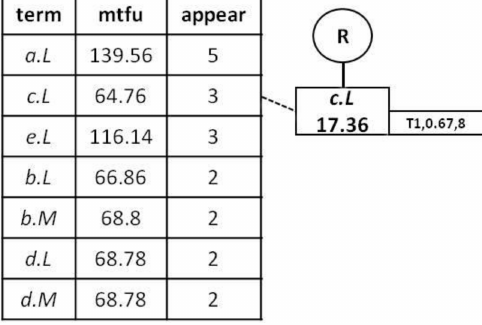
Figure 2. Inserting T 1 into the tree.